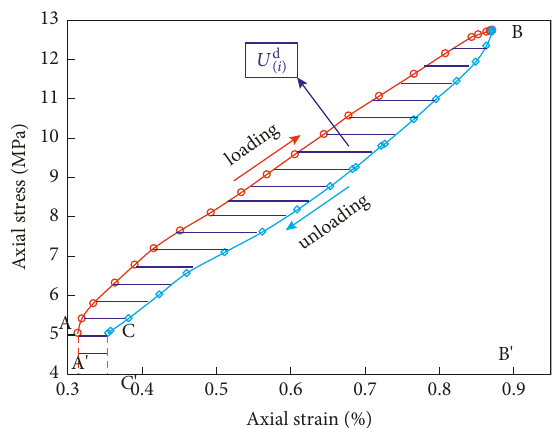
Figure 6: Calculation area of coal energy dissipation under tiered cyclic loading.